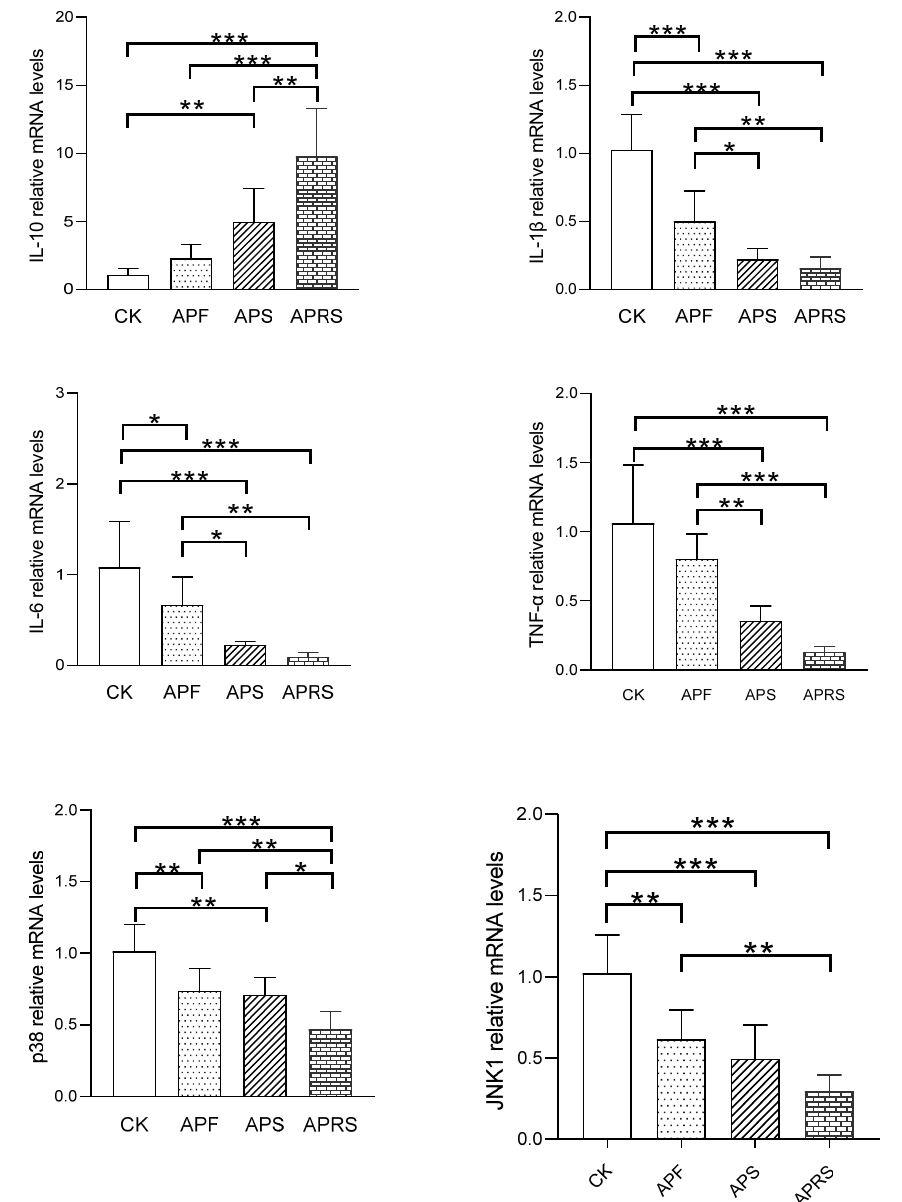
Figure 8. Effects of AP on the relative mRNA expression of inflammatory cytokines and genes related to MAPK signaling pathways in jejunum tissue of aged mice (* p < 0.05, ** p < 0.01, *** p < 0.001, one-way ANOVA with LSD test).